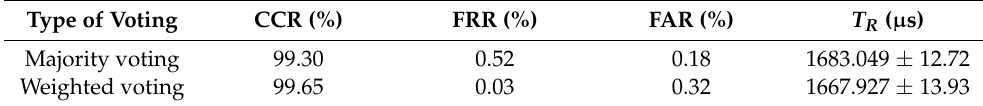
Table 11. Classification results for ensemble of heterogeneous